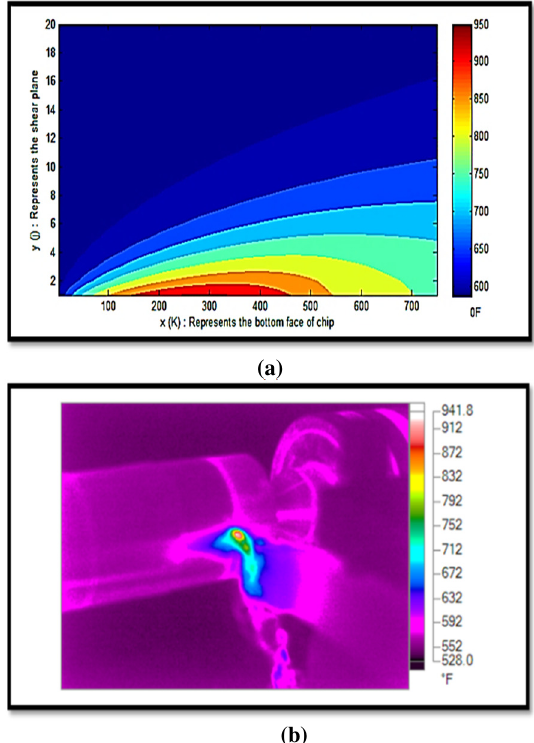
Fig. 18. Temperature fields of machining with spindle speed (400 r.p.m), feed (0.10mm/rev), depth (1.3 mm), (a) temperature distribution simulation, (b) experimental measuring of temperature using